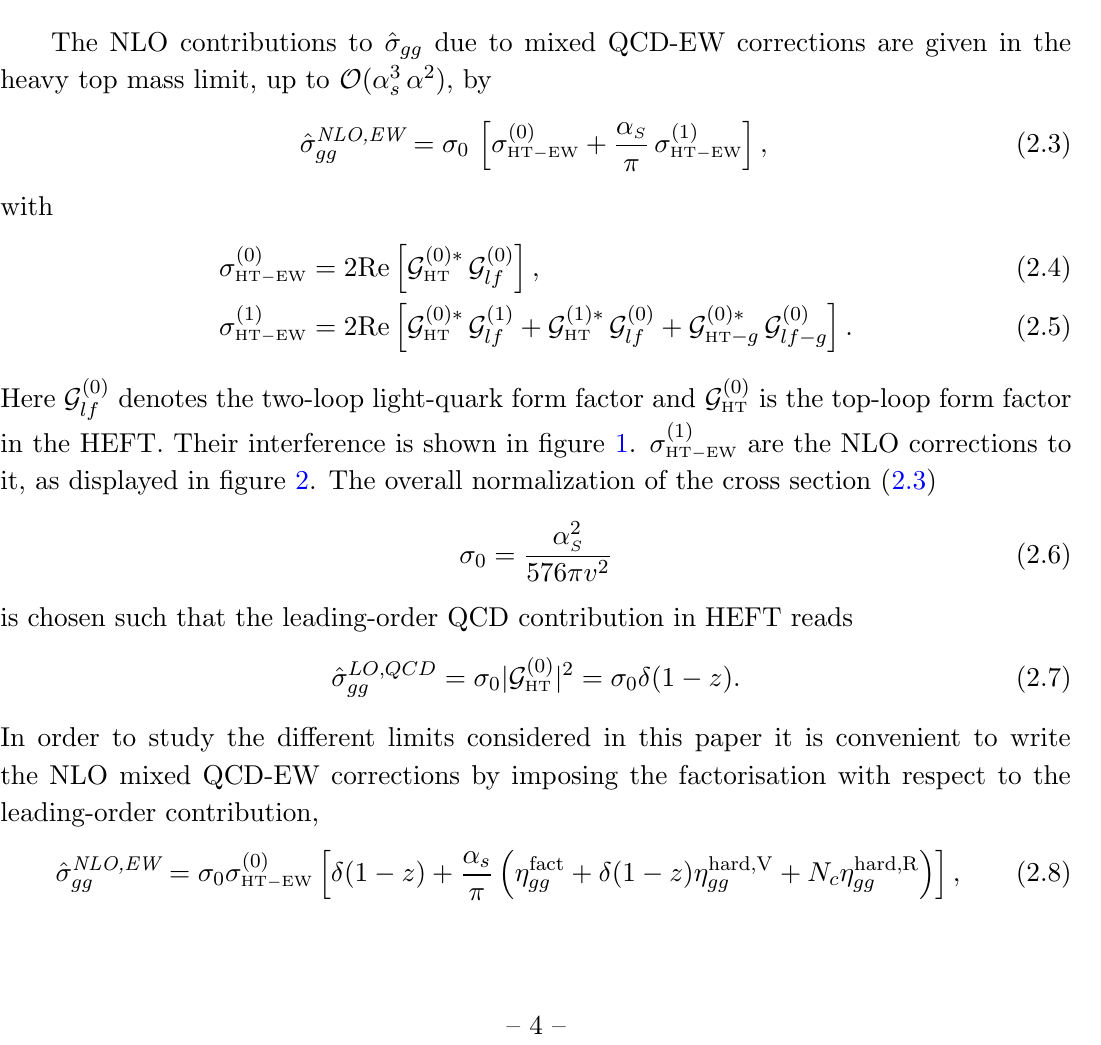
Figure 2. Examples of Feynman diagrams contributing to the O ( (cid:11) interference between the two-loop light-quark form factor and the top-loop form factor in HEFT. Figure 2a: contribution to G (0) (cid:3) G (1) . Figure 2b: contribution to G (1) (cid:3) lf HT to G (0) (cid:3) G (0) lf (cid:0) g HT (cid:0) g